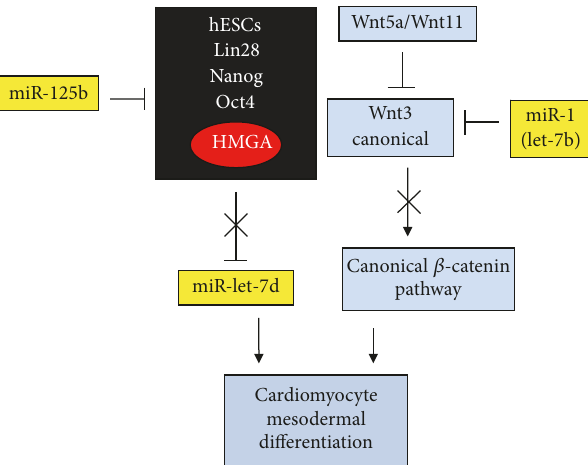
Figure 8: From hESCs to cardiomyocyte differentiation through miRs and Wnt activities. Symbols are the same as shown in Figure